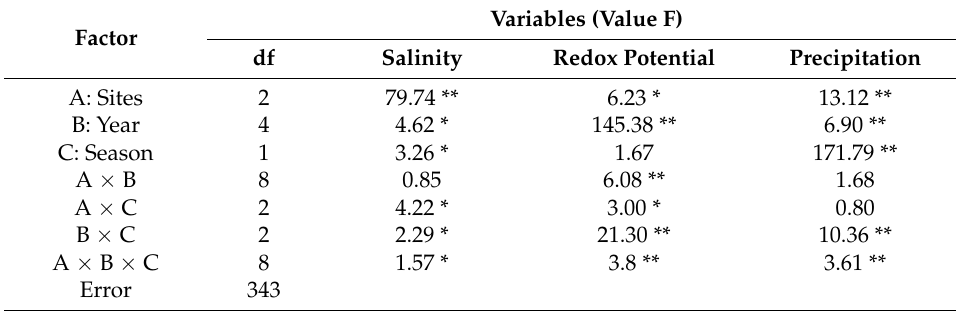
Table 3. Factorial ANOVA (three-factor) ( A ) sites, ( B ) year, and ( C ) seasons for salinity and precipitation between the three areas (Laguna de Terminos, Rio Champoton, and Los Petenes Biosphere Reserve) along the coast of Campeche (2009–2010,